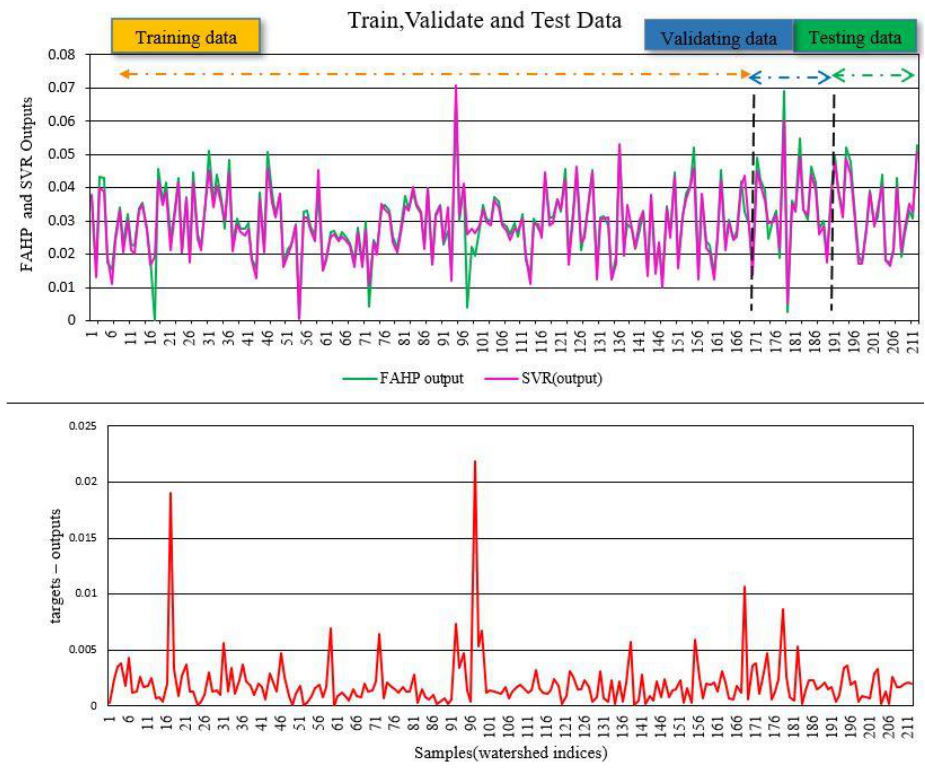
Figure 5. SVR performance for training, validating and testing data.